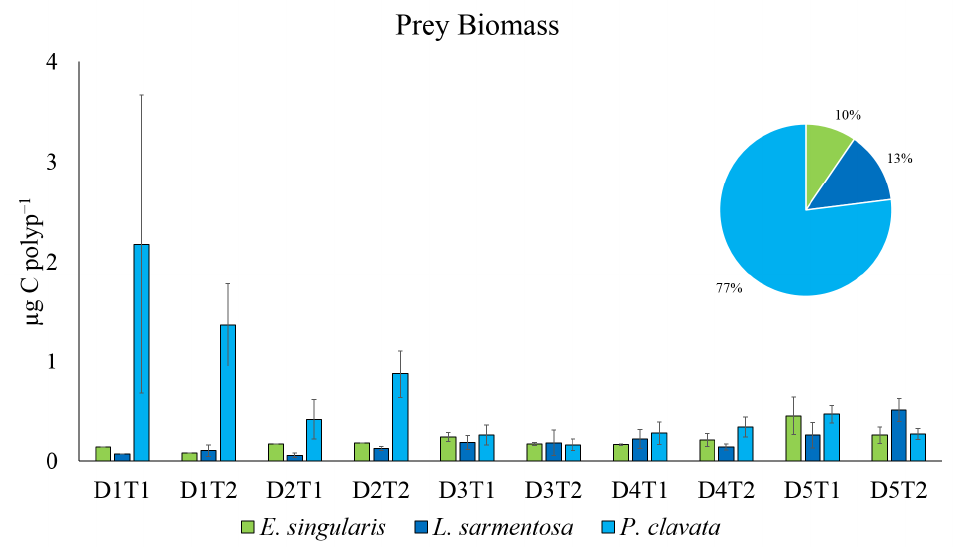
Figure 6. Prey biomass in fed polyps of the three investigated species.